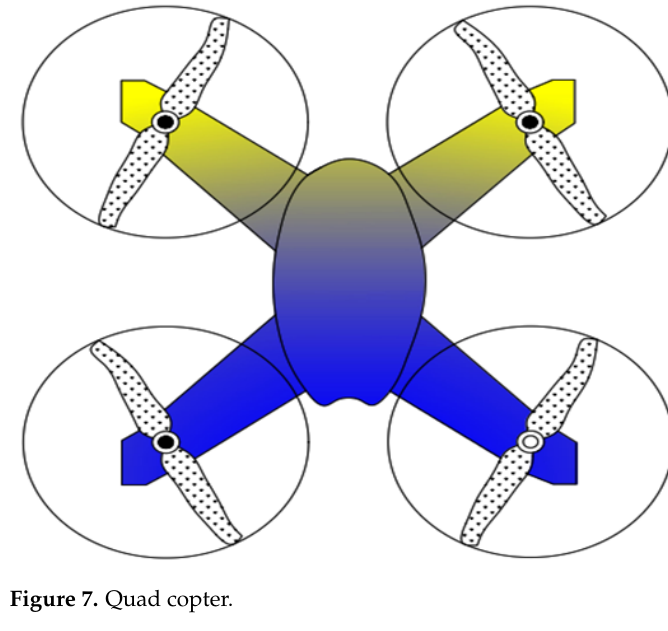
Figure 7. Quad copter.